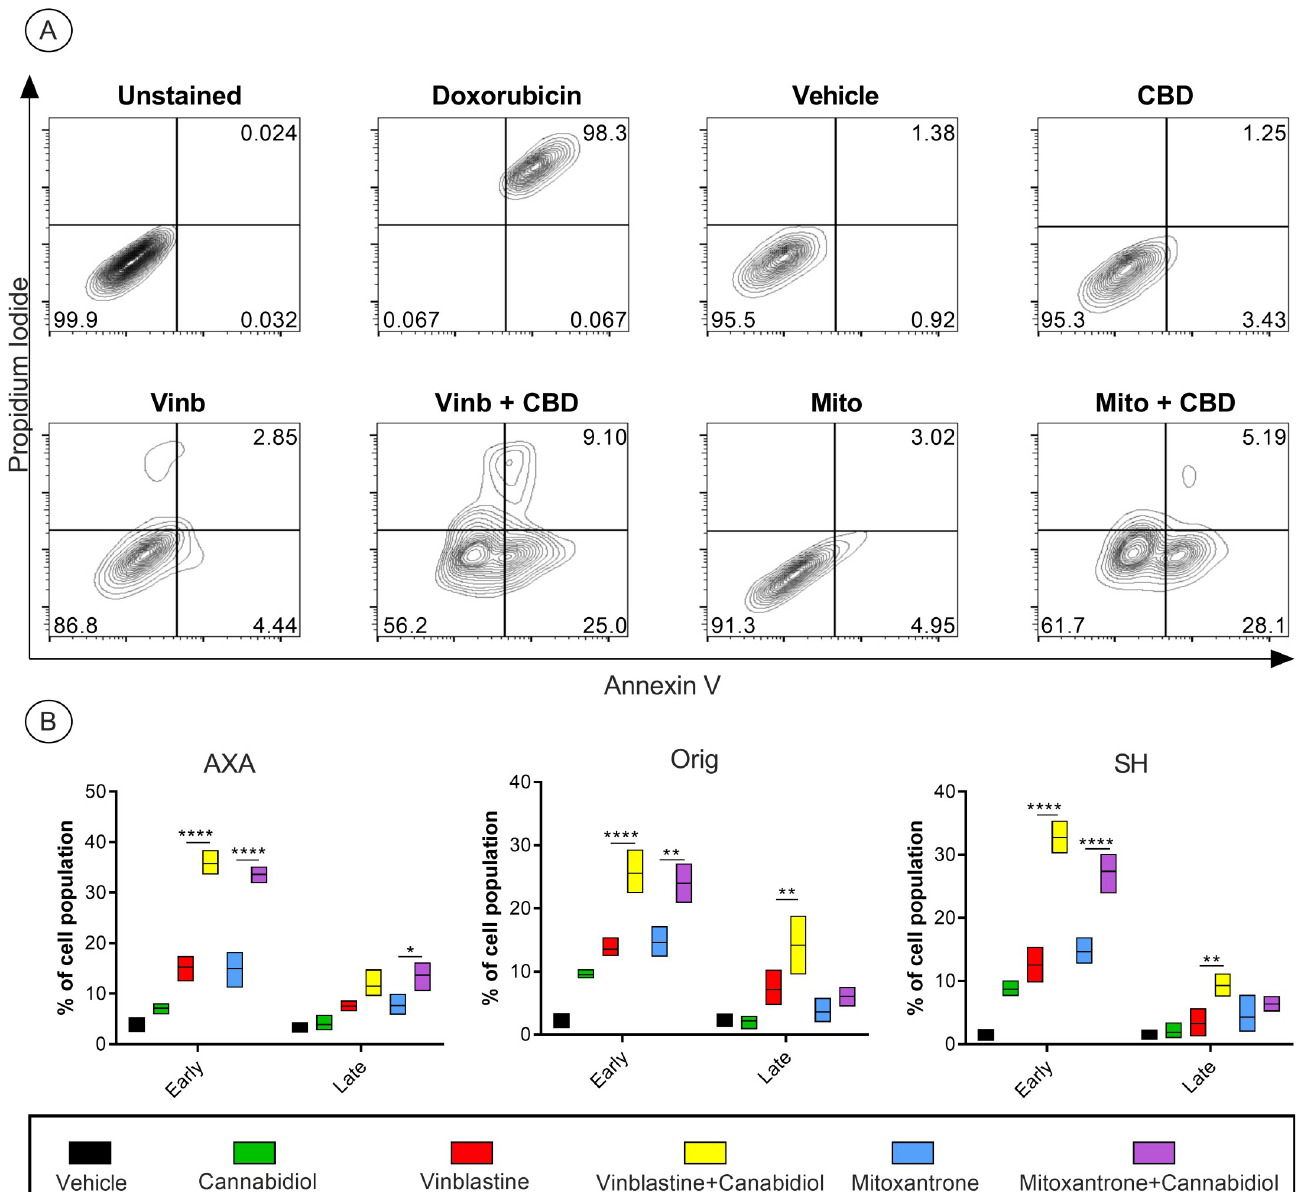
Fig 3. Piroxicam may enhance the cytotoxicity of mitoxantrone in canine UC cell lines. (A) Representative IC50 curves of canine UC cell lines treated with increasing doses of mitoxantrone, cannabidiol, vinblastine, and carboplatin in combination of 20 μ M piroxicam or respective vehicle control for 24 hours. Graphs represent mean ± SD of three technical and biological replicates. (B) Log IC50 interpolated from IC50 curves in combination with and without piroxicam are presented with median ± range (N = 9). Significance was reported at � P < 0.05, �� P < 0.1, ��� P < 0.001, ���� P < 0.0001. UC, urothelial carcinoma; IC50, half- maximal inhibitory concentration, P, piroxicam; Mito, mitoxantrone; Vinb, vinblastine; Carbo, carboplatin.